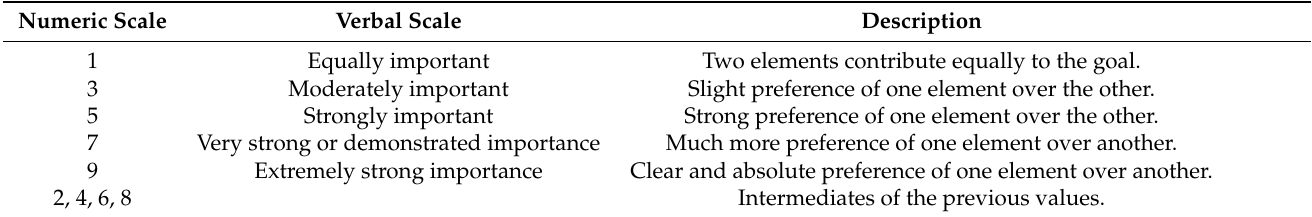
Table 4. Pairwise comparison scale of each factor proposed in Saaty’s scale.